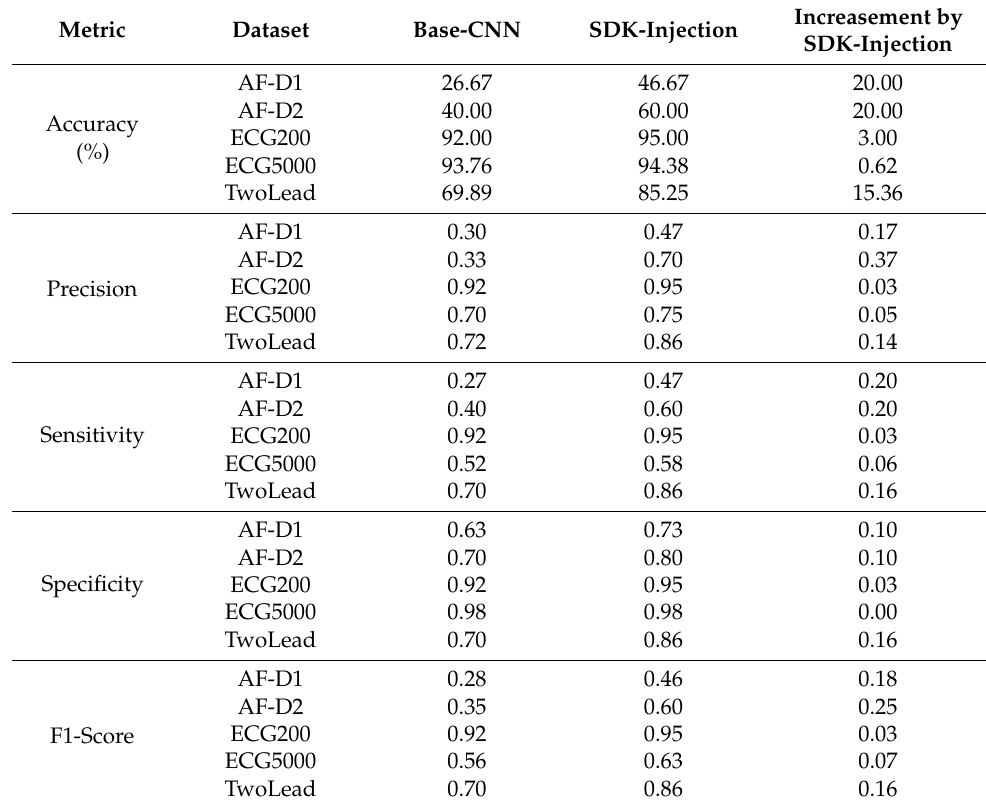
Table 2. Performance evaluation of Base-CNN and